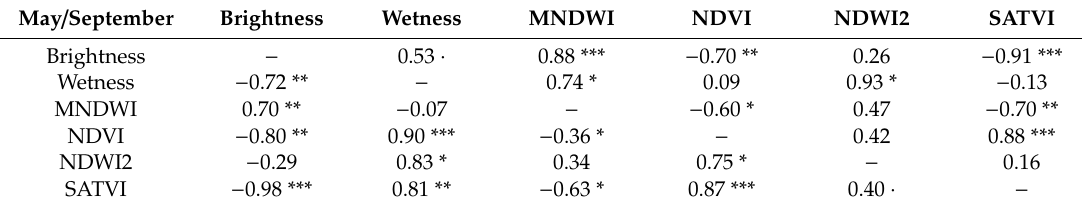
Table 2. Correlation between vegetation indices for the two sampling periods: May (below the diagonal) and September 2017 (above the diagonal). Brightness: tasseled-cap brightness, wetness: tasseled-cap wetness, MNDWI: modified normalized di ff erence water index, NDVI: normalized di ff erence